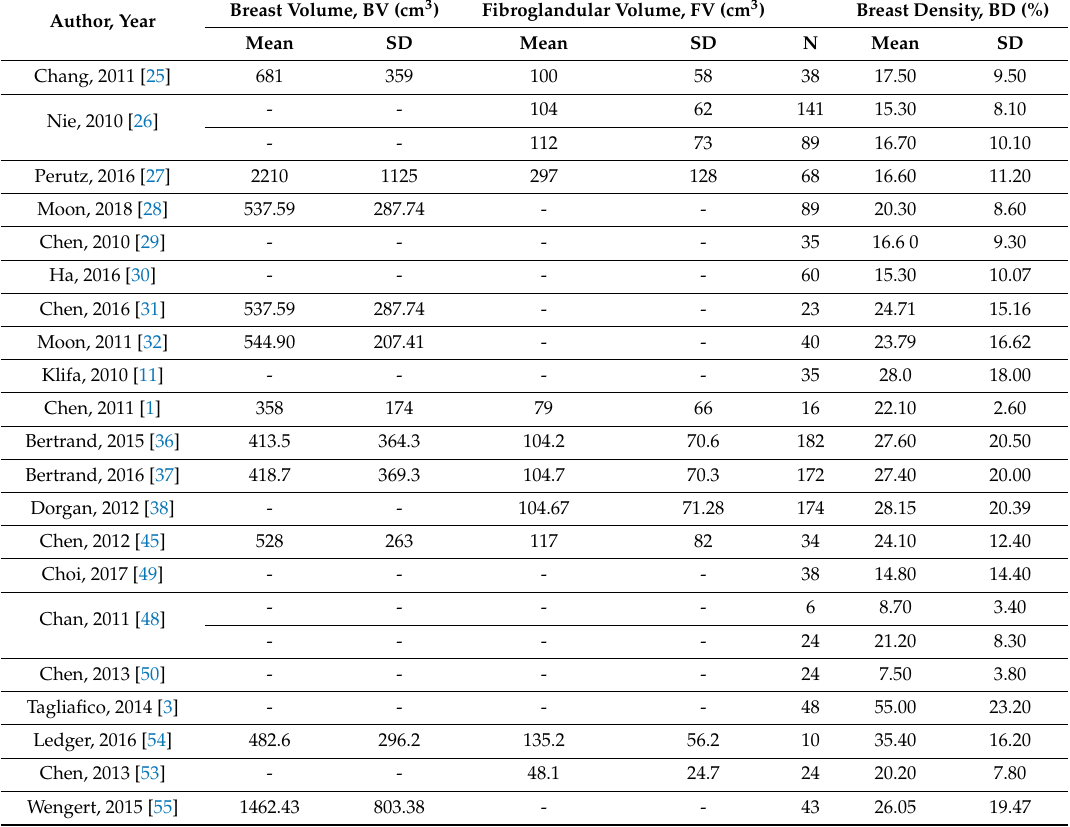
Table 2. Sample size, Mean, and SD of breast volume, fibroglandular volume, and percent of breast density of the (21) included studies in the subgroup